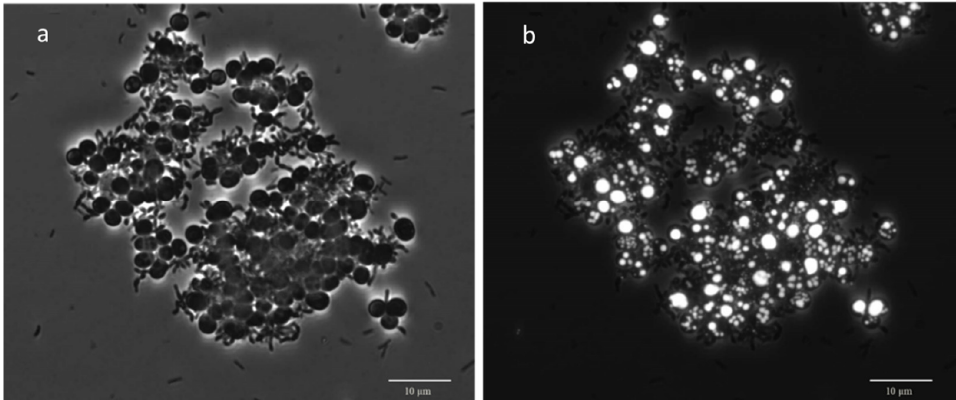
Figure 2. Microscopic images of the synthetically fed culture S5 operated under a permanent feast (PF) regime. ( a )—Phase contrast; ( b )—fluorescence image of Nile blue staining indicating PHA granules, mostly in cocci bacteria.